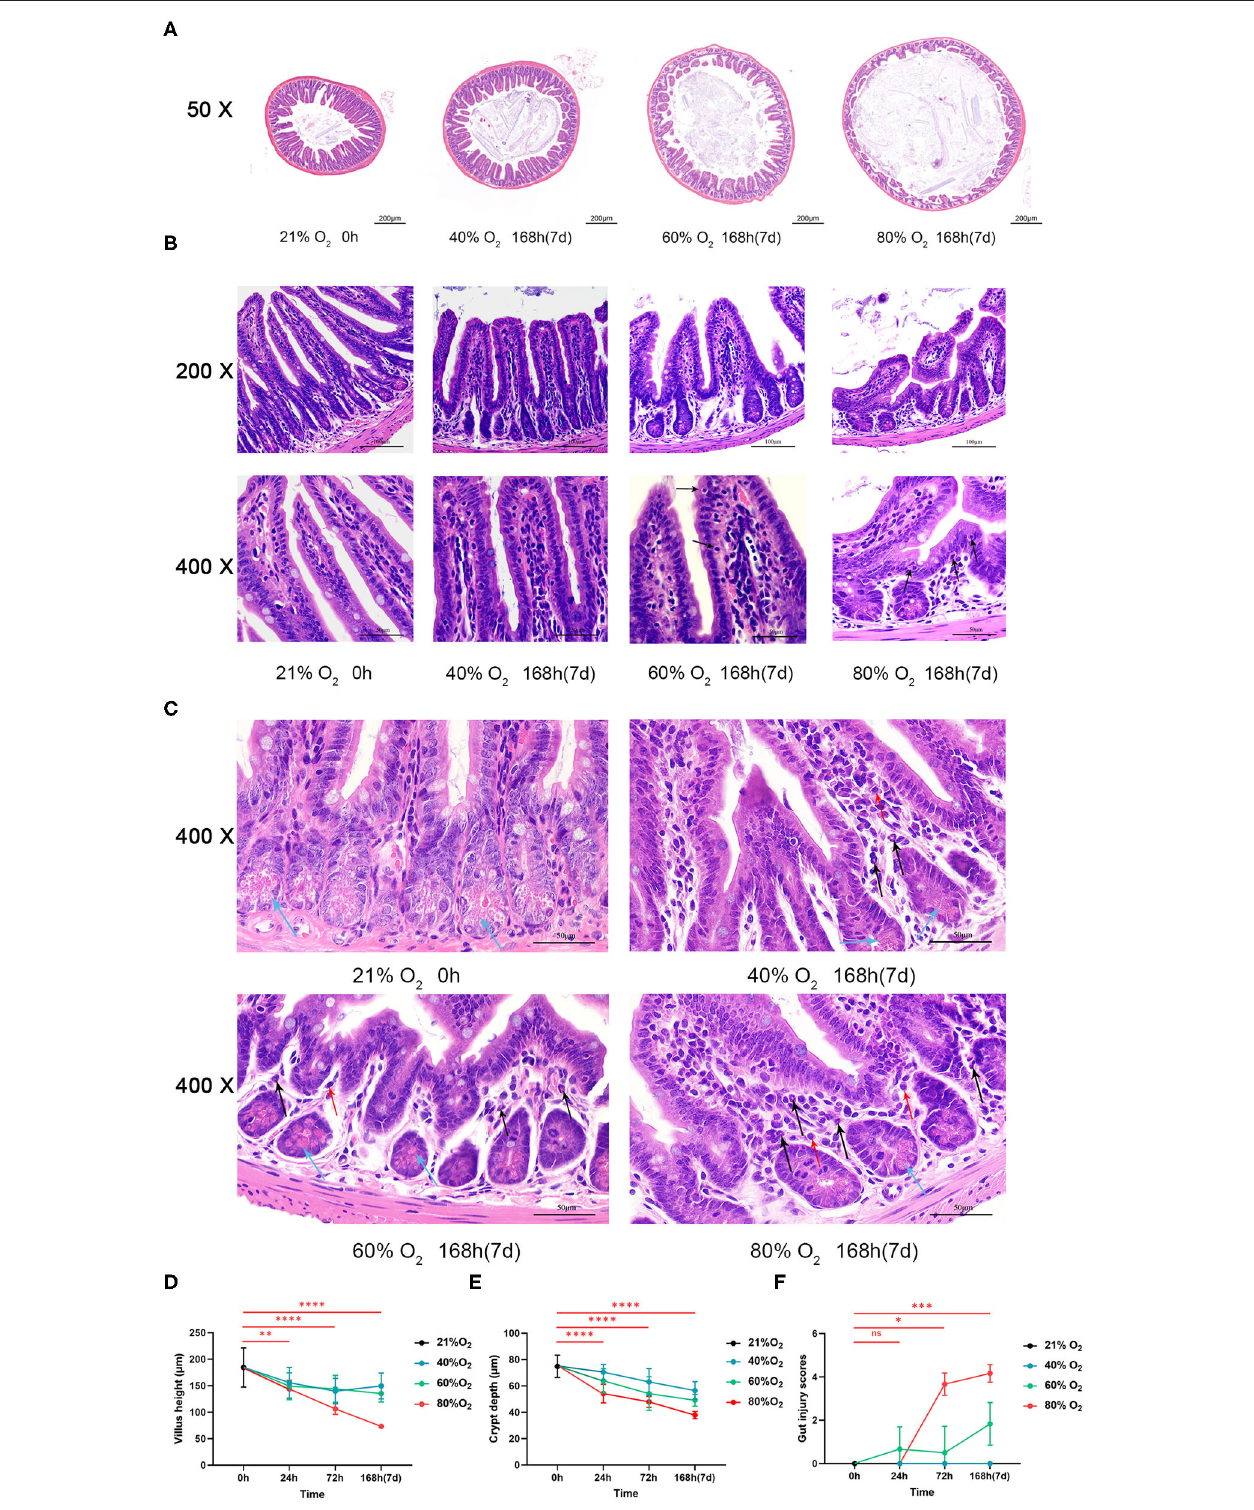
FIGURE 1 | Hyperoxia induces time- and dose-dependent intestinal histopathological injury ( n = 6). (A) Representative intestinal sections from the control group and the oxygen groups (FiO 2 of 40, 60, and 80%) were exposed for 168h (7 d) at low magnification (50 × ). (B) Representative intestinal sections from the control group and the oxygen groups (FiO 2 of 40, 60, and 80%) were exposed for 168h (7 days) at high magnification (200 × and 400 × ). The mice reared in room air had a normal